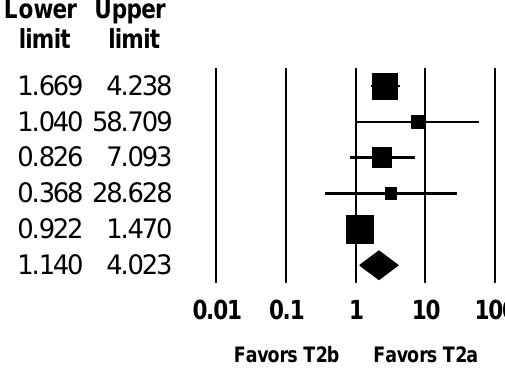
Figure 2. Forest plot of overall survival in resected T2a and T2b GBC patients. The figure depicts individual trials as filled squares with relative sample size and the 95% confidence interval (CI) of the difference as a solid line. The diamond shape indicates the pooled estimate and uncertainty for the combined effect.